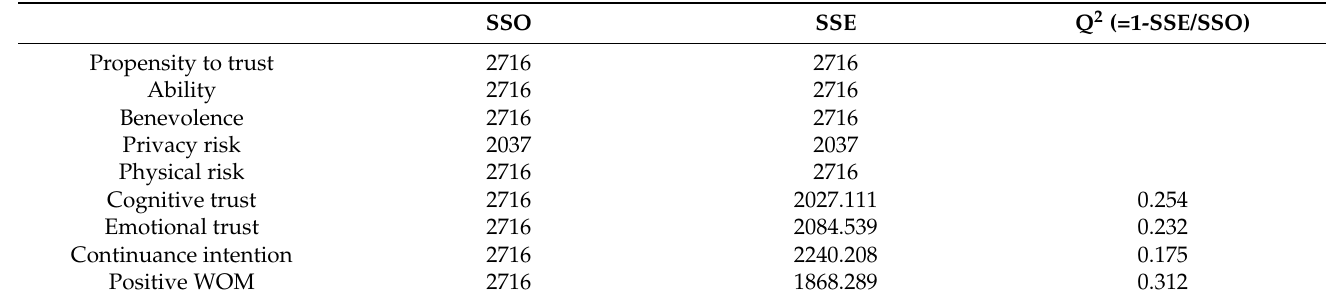
Table 10. Results of Q 2